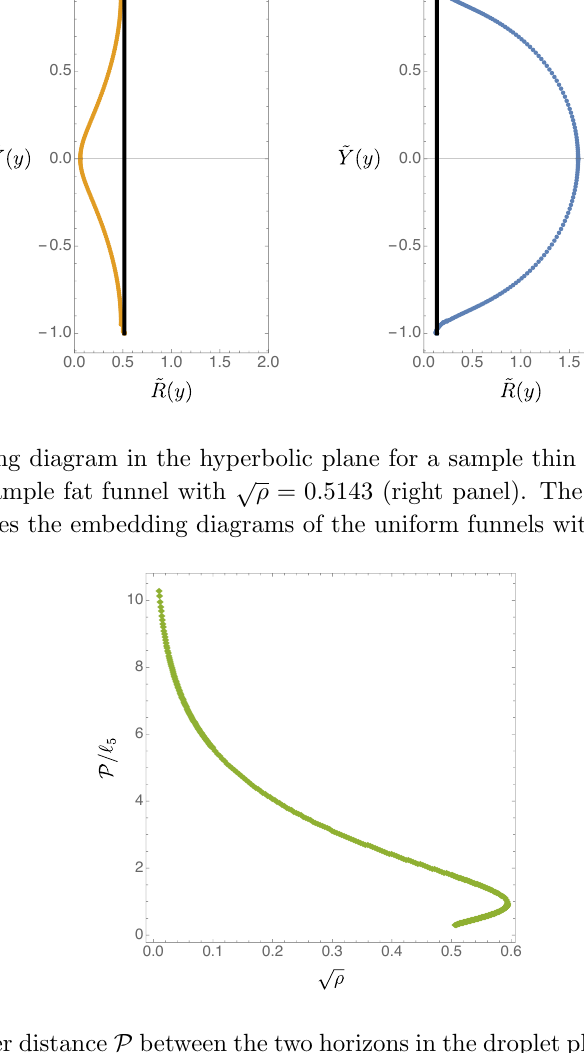
Figure 8 . The proper distance P between the two horizons in the droplet phase as a function of